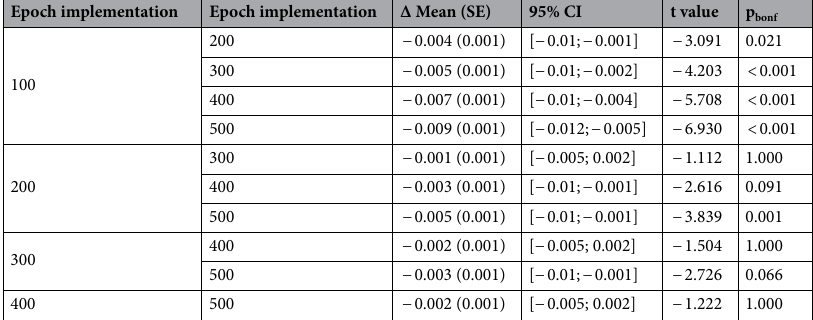
Table 3. Within-subjects effects of the learning iteration parameter (epoch modulation).